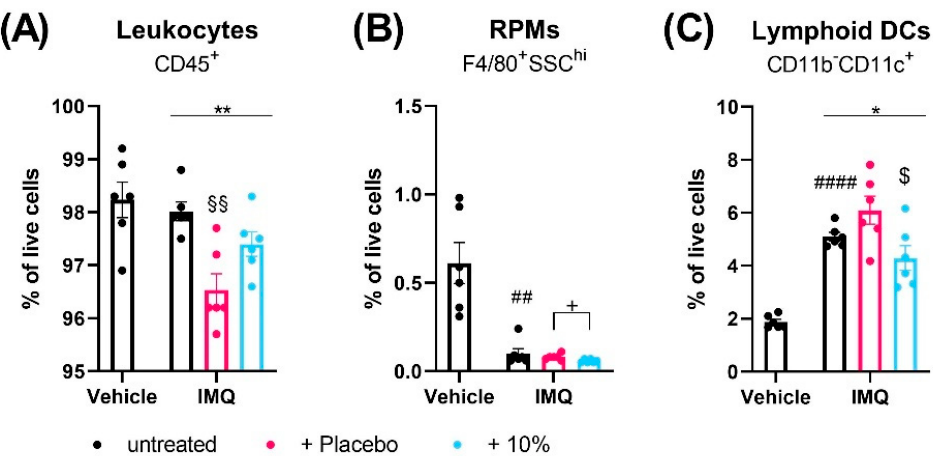
Figure 3. Diacerein affects spleen immune cell populations in IMQ-induced psoriasis. Flow cytometric analysis of CD45 + leukocytes ( A ), red pulp macrophages (RPMs) ( B ), and CD11c + lymphoid dendritic cells (DCs) ( C ) in spleen single cell suspensions in mice on day 4 after receiving treatment for